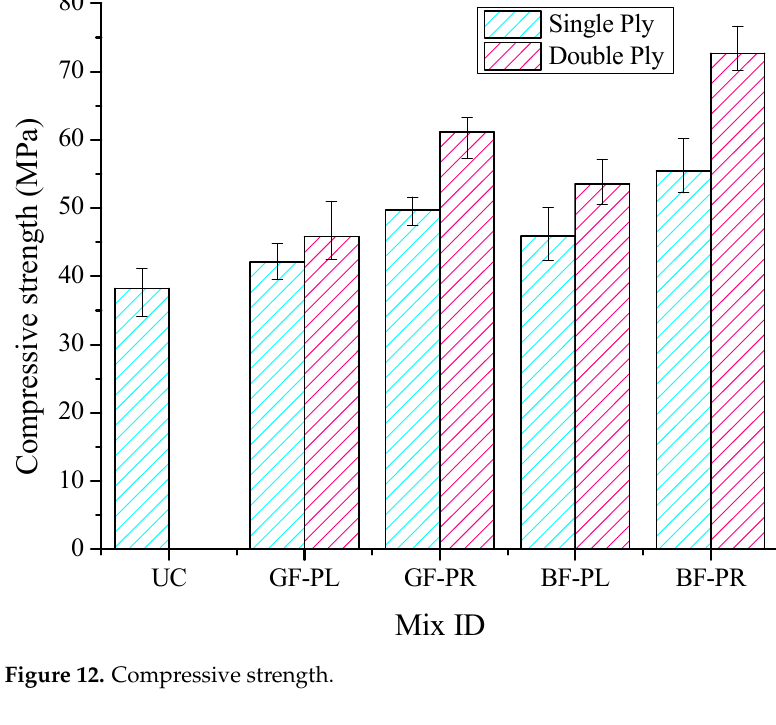
Figure 12. Compressive strength.